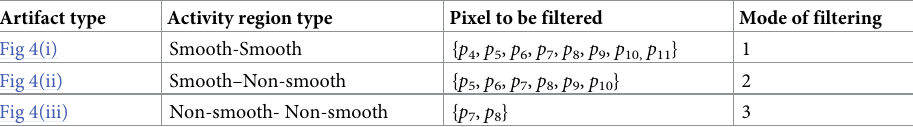
Table 1. Pixel filtering